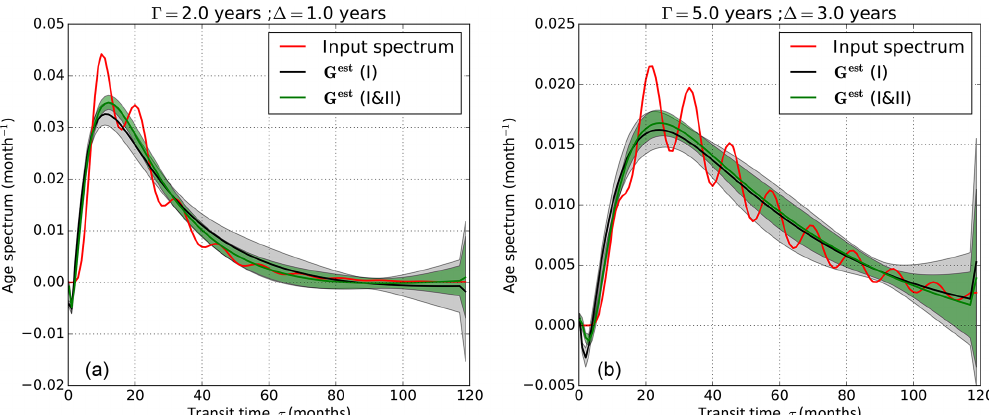
Figure 9. Input age spectra (red), defined using Eq. (33) with A = 0 . 3, φ = π (for left and right panels), (cid:48) = 2 years and (cid:49) = 1 year (a) and 2 (cid:48) = 5 years, (cid:49) = 3 years (b) . Retrieved age spectra using (black) parent decaying tracers only or (green) both parent and daughter tracers. The full lines are average retrieved age spectra over 100 retrievals from 100 sets of pseudo-tracer observations. The gray and green shadings correspond to ± the standard deviation of the 100 retrievals and show the dispersion-noise-induced uncertainty.